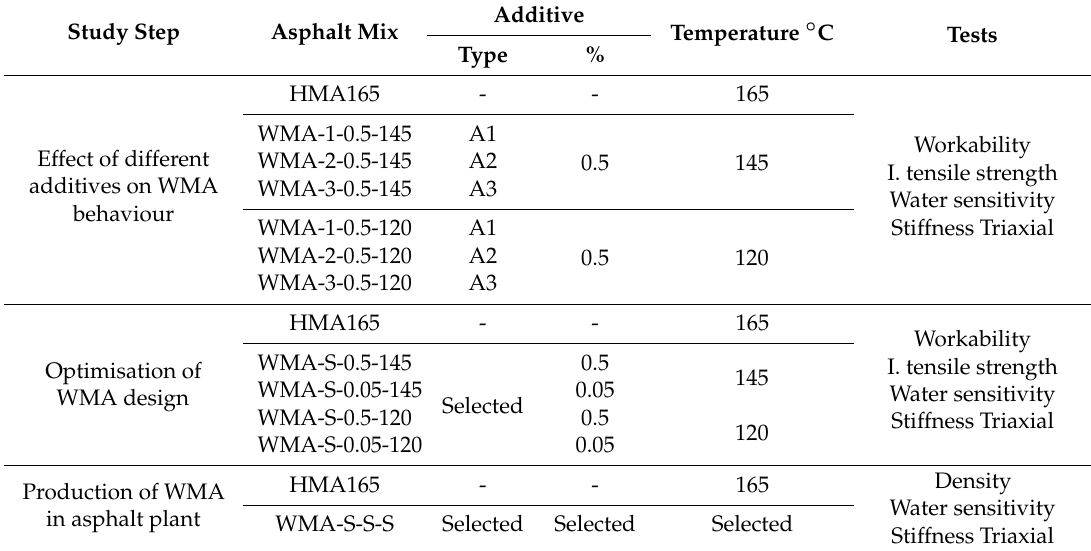
Table 3. Testing